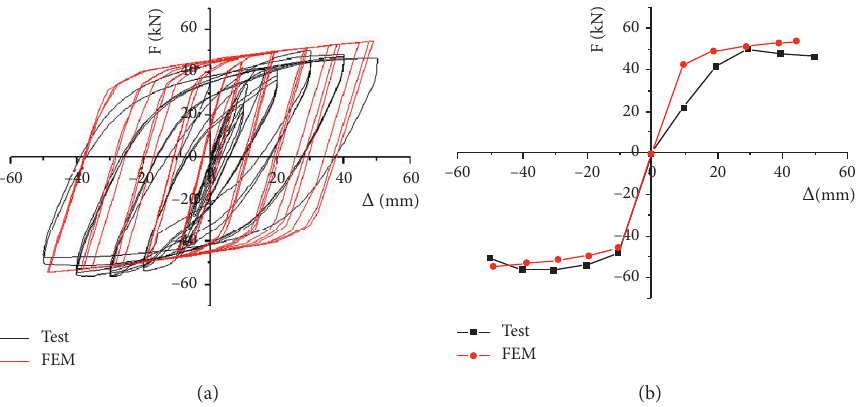
Figure 18: Hysteretic curve and envelope curve of SRC-3. (a) Hysteretic curve. (b) Envelope curve.